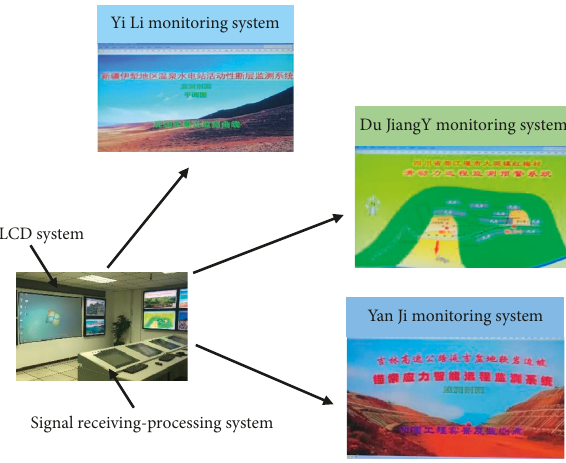
Figure 9: Indoor monitoring